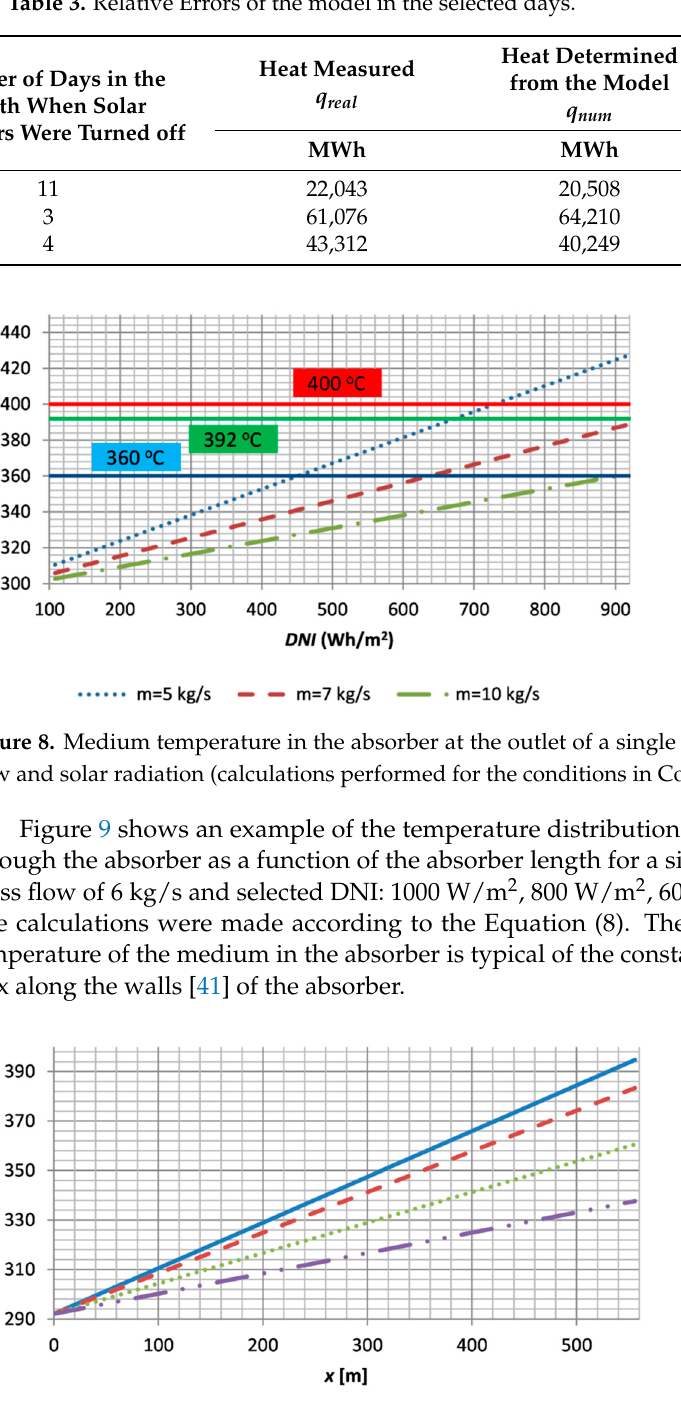
Table 3. Relative Errors of the model in the selected days.